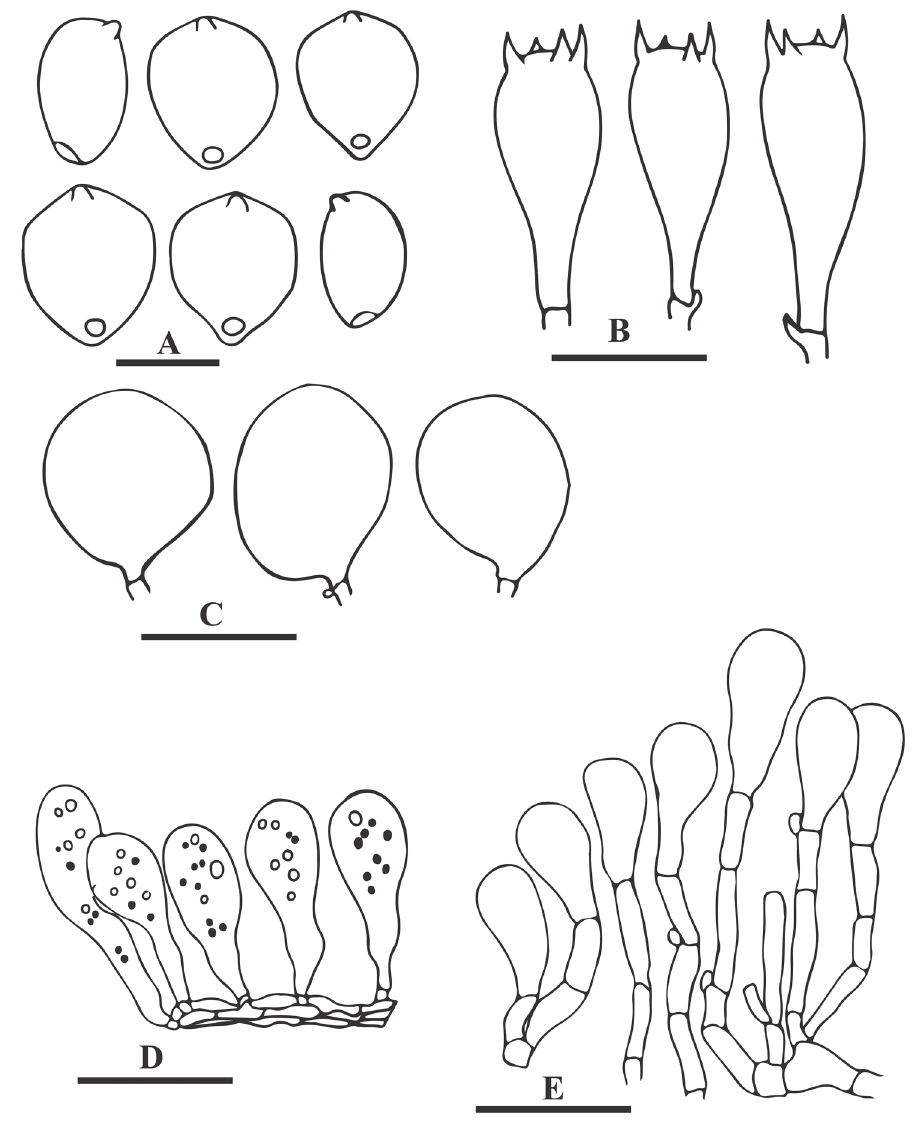
Figure 9. Anatomical features of Parasola lilatincta (LAH-SHP-8). A Basidiospores B Basidia C Pleuro- cystidia D Cheilocystidia E Pileipellis. Scale bars: A = 10 µm, B–E = 20 µm.